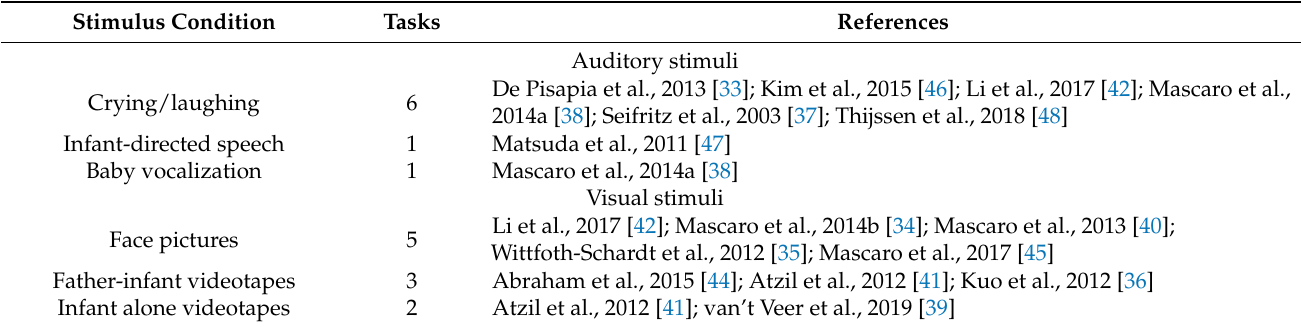
Figure 2. Offspring age range for the included studies [34–47]. Note. Two studies were not included because the data were not available (De Pisapia et al., 2013) [33] or were related to unborn infants (Thijssen et al., 2018) [48]. Please, note that in Abraham et al. (2014) [44] and Matsuda et al. (2011) [47] the minimum and maximum ages were not available. Nonetheless, mean and standard deviations were reported, and an estimated range was obtained by applying ± two standard deviations to mean age. Table 2. Overview of the stimuli used in paternal brain